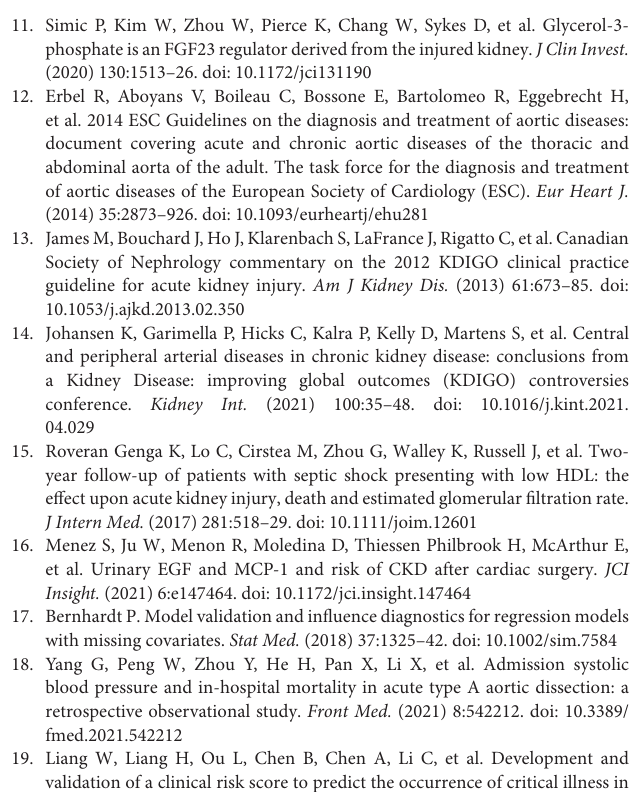
Supplementary Figure 1 | Flow chart of patient enrollment. Supplementary Figure 2 | Feature selection using the least absolute shrinkage and selection operator (LASSO) binary logistic regression model. (A) LASSO coefficient profiles of all variables. (B) Tuning parameter ( λ ) selection in the LASSO model used 10-fold cross-validation via minimum criteria. Supplementary Figure 3 | Comparison of admission LPA stratified by